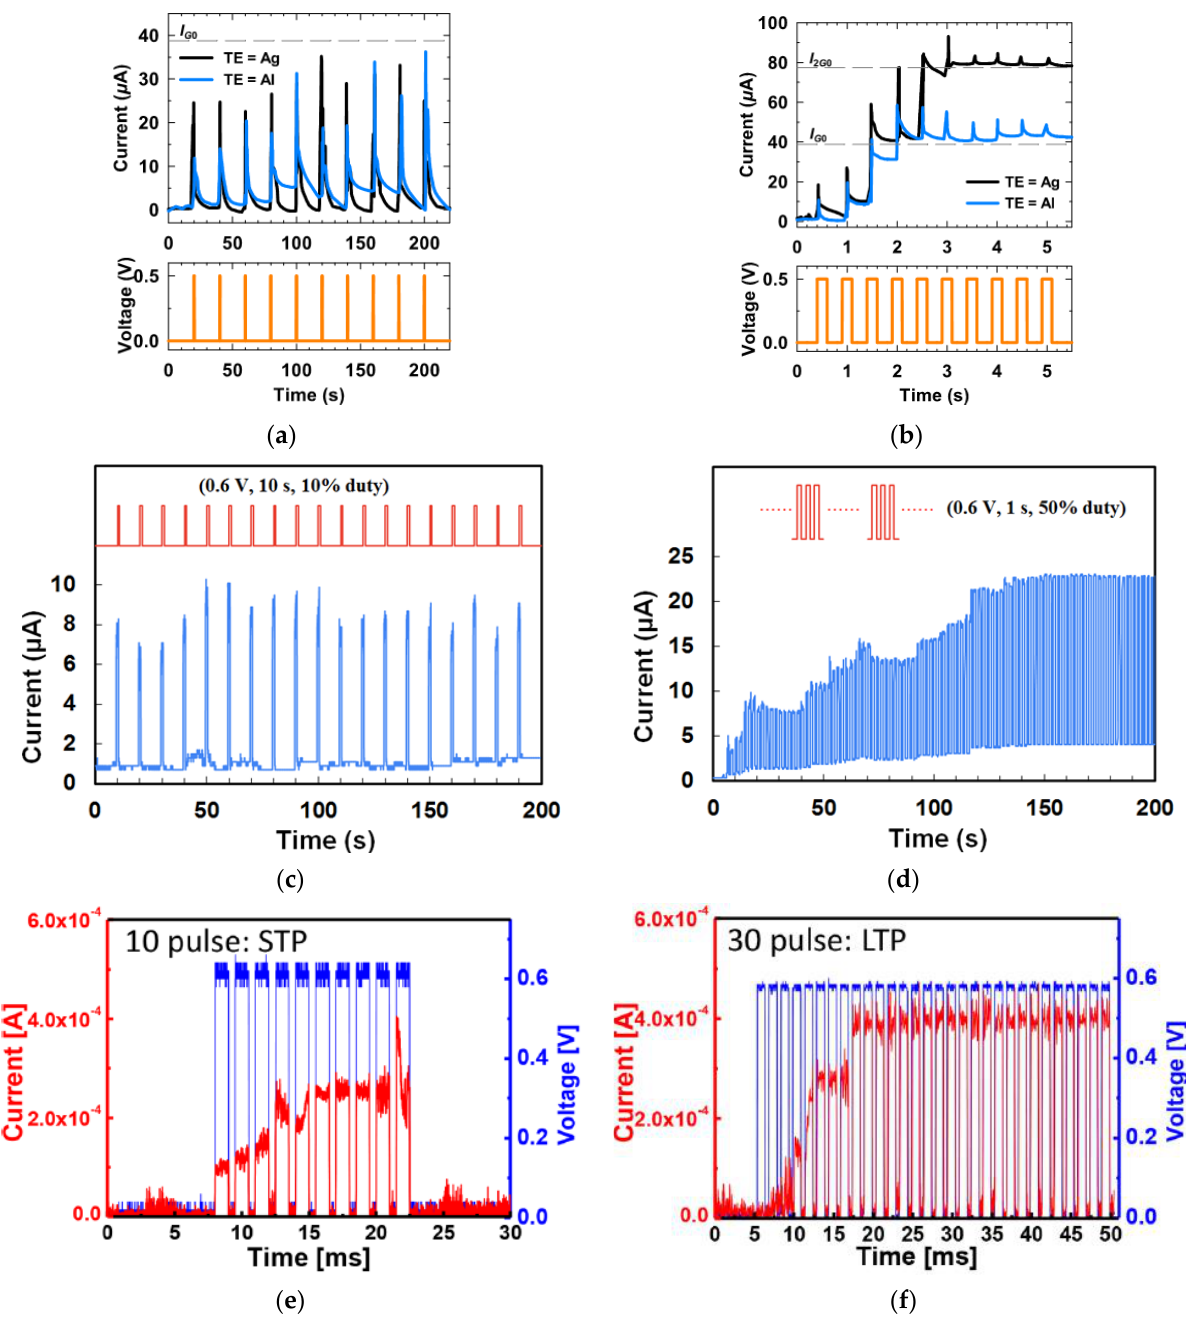
Figure 3. STM, LTM, and STM-to-LTM transition in synaptic devices based on ( a , b ) Aloe polysaccharide [9] and ( c , d ) honey [17] achieved by shortening the time interval between stimulation pulses and ( e , f ) ι -carrageenan [27] achieved by increasing the pulse number.